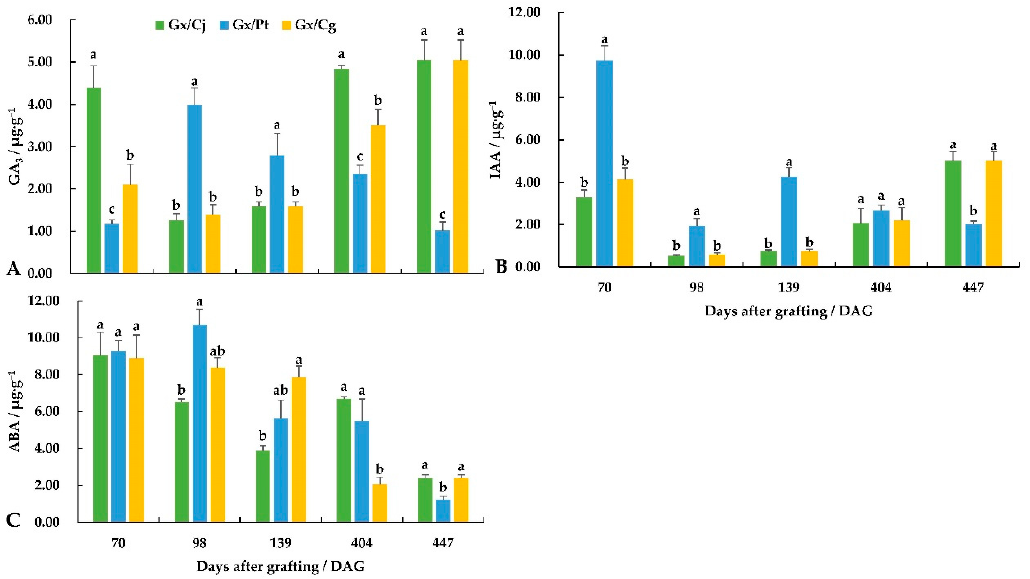
Figure 4. The changes in GA 3 ( A ), IAA ( B ) and ABA ( C ) content in the leaves for different stages of ‘Guanxi Miyou’ grafted onto three citrus rootstocks. Different lowercase letters indicate a significant difference at the 0.05 level at the same sampling stage.